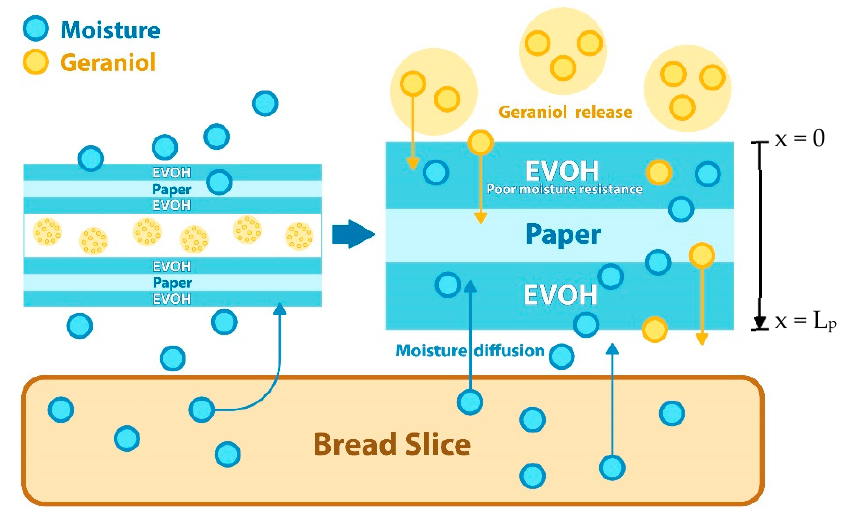
Figure 4. Schematic diagram describing the diffusion mechanism in bread packaging (reproduced with permission from Petchwattana et al. (2021) [70]).